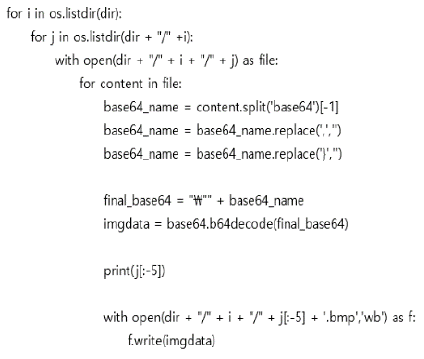
Figure 4. Conversion Process .